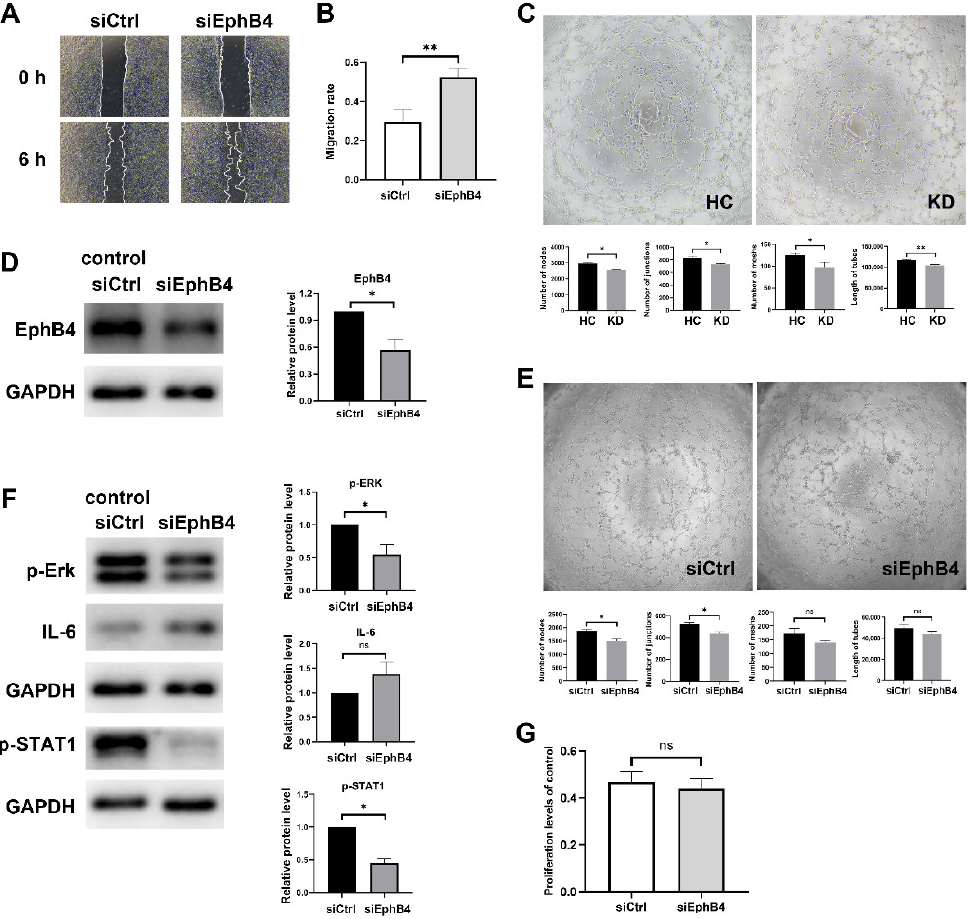
Figure 3. Effects of EphB4 inhibition on cell migration and angiogenesis ability. ( A , B ) HCAECs were transfected with siRNA for 24 h. The cell migration ability was measured by wound-healing assay and analyzed using Image J software. ( C ) HCAECs were pretreated with a medium containing 15% KD or HC sera for six hours and then were plated on Matrigel. ( D ) The protein level of EphB4 was detected in the siEphB4 group. ( E ) HCAECs were plated on Matrigel after transfected with siEphB4 or control siRNA for 24 h. ( F ) Effects of EphB4 inhibition on the protein expressions of p-ERK, IL-6 and p-STAT1 were analyzed by Western blot. Full-length blots are presented in Supplementary Figure S1. ( G ) Cell proliferation did not show significant changes after knockdown. All results are expressed as the mean ± SEM. * p < 0.05, ** p < 0.01 versus the control group.